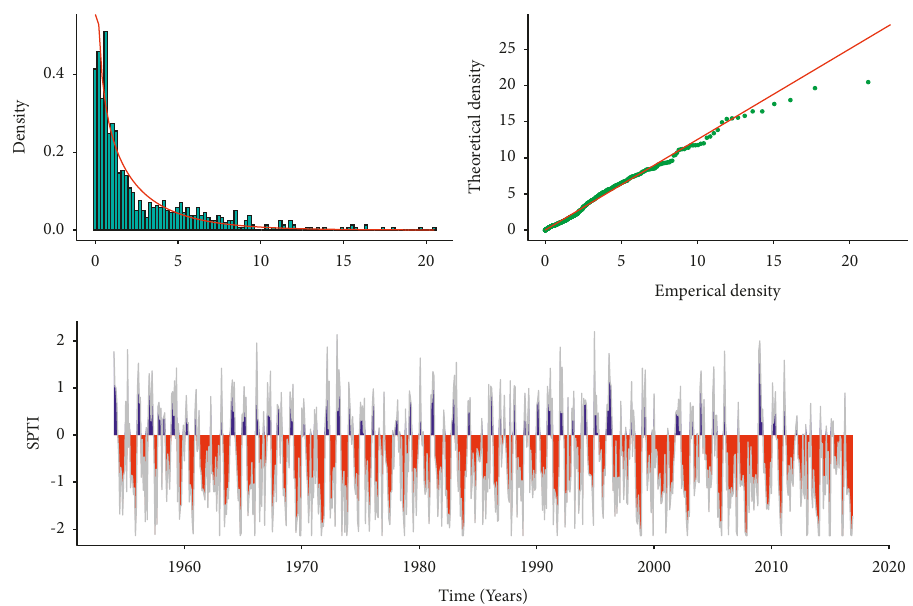
Figure 3: Histogram, QQ-plot, and temporal plot of SPTI-1 at Astore station.